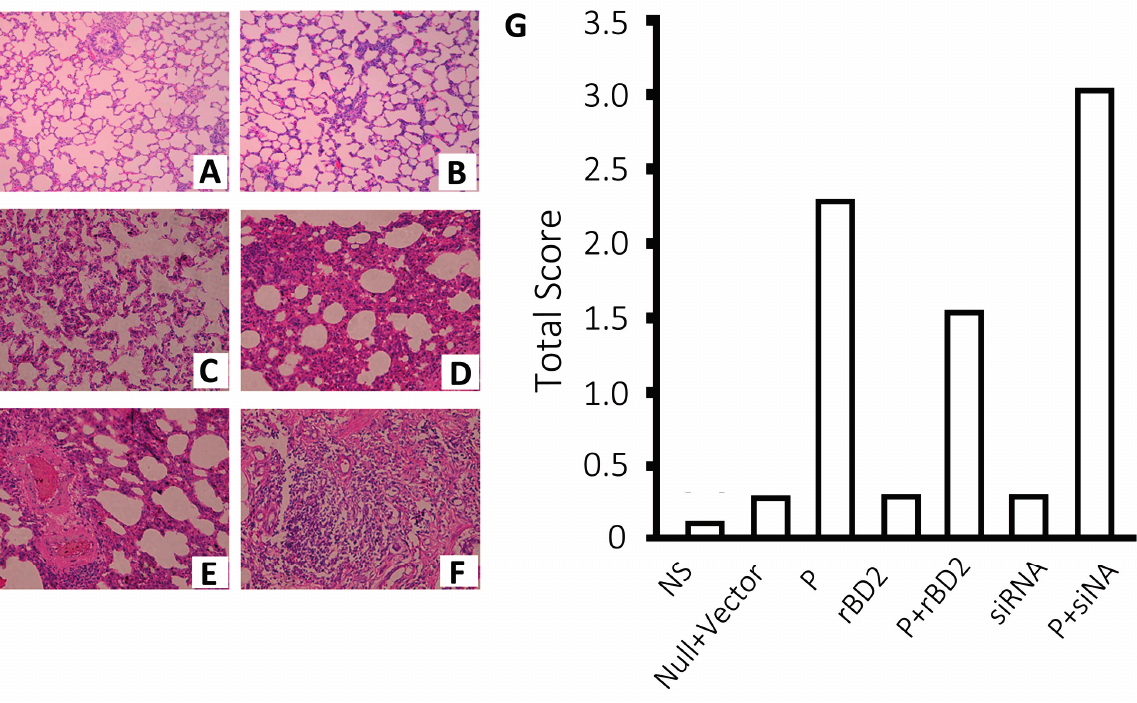
Figure 2. Histological images of lungs of rats subjected different treatment. Representative microscopic images of lungs in ( A ) group treated null lentivirus; ( B ) group treated with rBD2 expression lentivirus; ( C ) group pretreated with rBD2 shRNA lentivirus; ( D ) Pseudomonas aeruginosa infected Group; ( E ) Pseudomonas aeruginosa infected group pretreated with rBD2 expression lentivirus and ( F ) Pseudomonas aeruginosa infected Group pretreated with rBD2 shRNA lentivirus 24 h after injection of Pseudomonas aeruginosa when applied; ( G ) Average total pathology scores of the normal saline group (NS), group treated with null lentivirus, Pseudomonas aeruginosa infected group (P), group treated with rBD2 expression lentivirus ( rBD2 ), Pseudomonas aeruginosa infected group pretreated with rBD2 expression lentivirus (P + rBD2 ), group pretreated with rBD2 shRNA lentivirus (shRNA) and Pseudomonas aeruginosa infected group pretreated with rBD2 shRNA lentivirus (P +